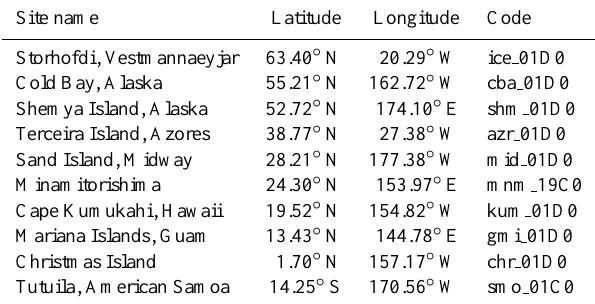
of airport locations are presented in Table 3. Solid black circles de- note locations of the selected GLOBALVIEW-CO 2 marine bound- ary layer sites. Table 4. Selected surface marine boundary layer sites of GLOBALVIEW-CO 2 network.